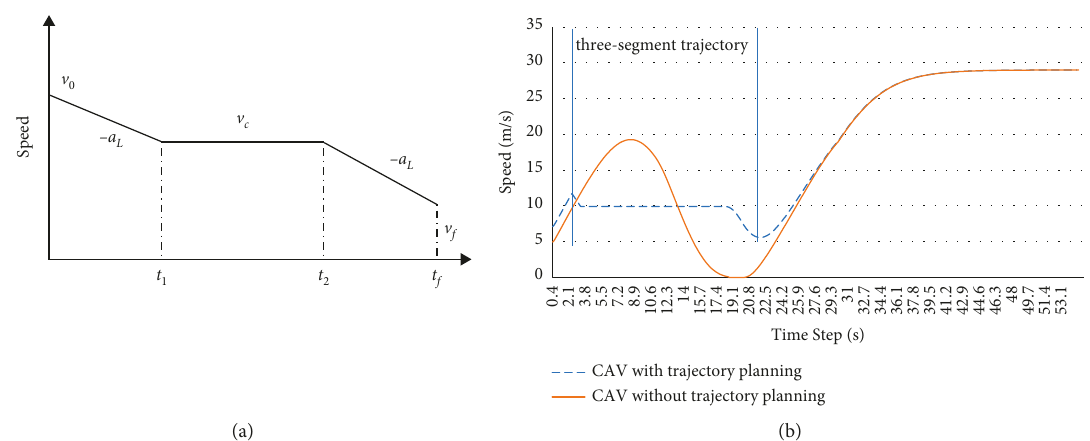
Figure 3: A general optimal trajectory for the deceleration scenario. (a) Theoretical three-segment trajectory in deceleration case (revised from (b) Three-segment trajectory in simulation.